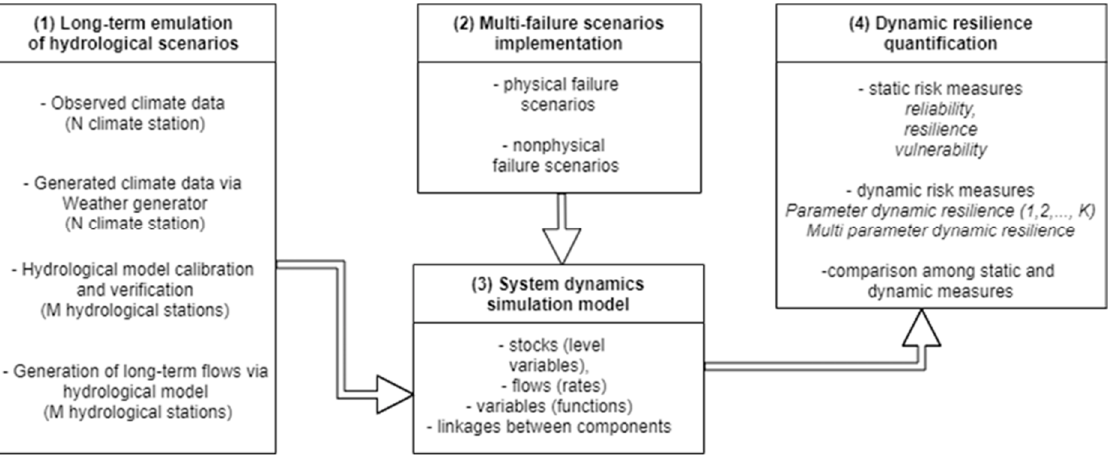
Figure 1. Chart flow diagram for quantifying multi-parameter dynamic resilience for complex reservoir systems.